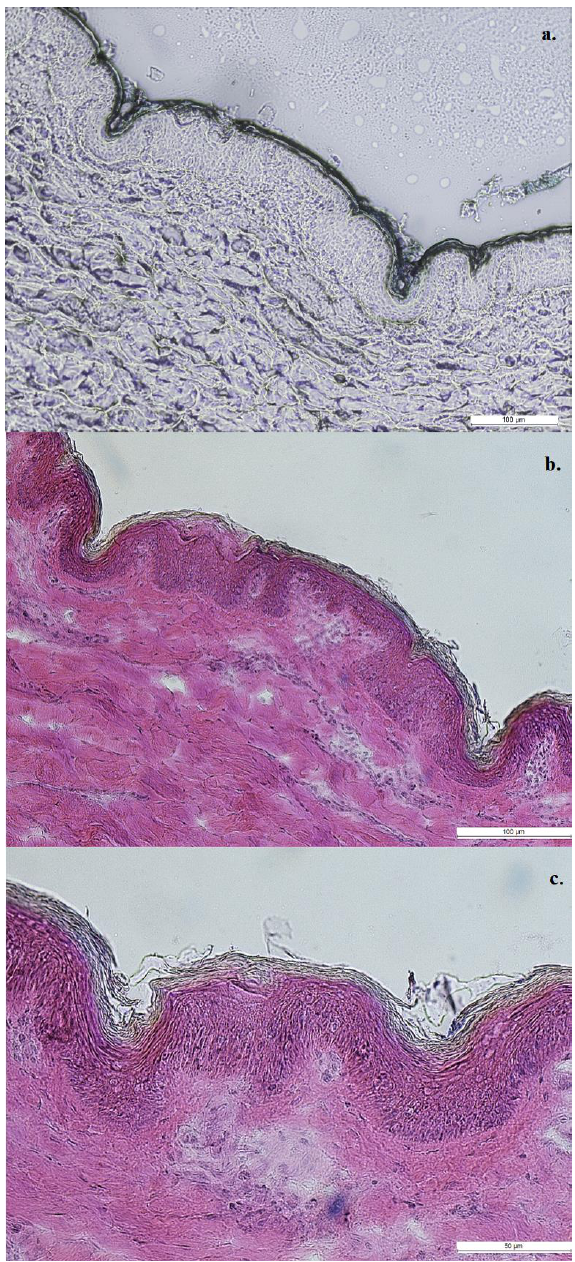
Figure 4. Histological evaluation of (a) the formation of gel in situ in successfully microporated skin (methylene blue solution used to stain the formulation) followed by (b, c) hematoxylin and eosin staining. Scale bar represents (a, b) 100 µm and (c) 50 µm.